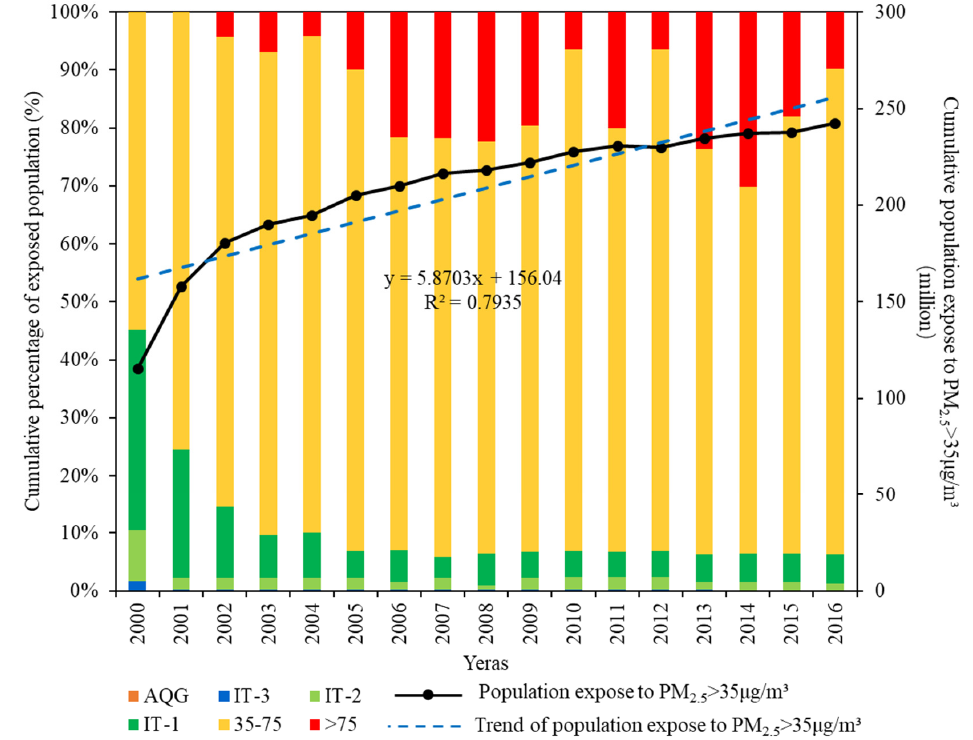
Figure 3. Changes in the proportion of the population exposed to different PM 2.5 concentrations